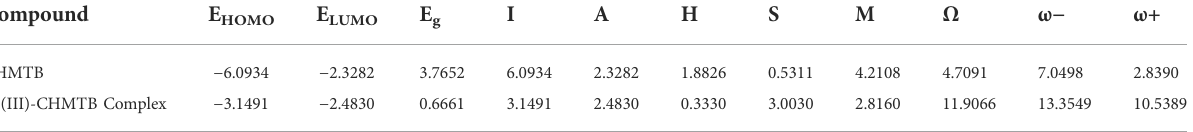
TABLE 6 Energy gap and quantum chemical molecular descriptors in eV.